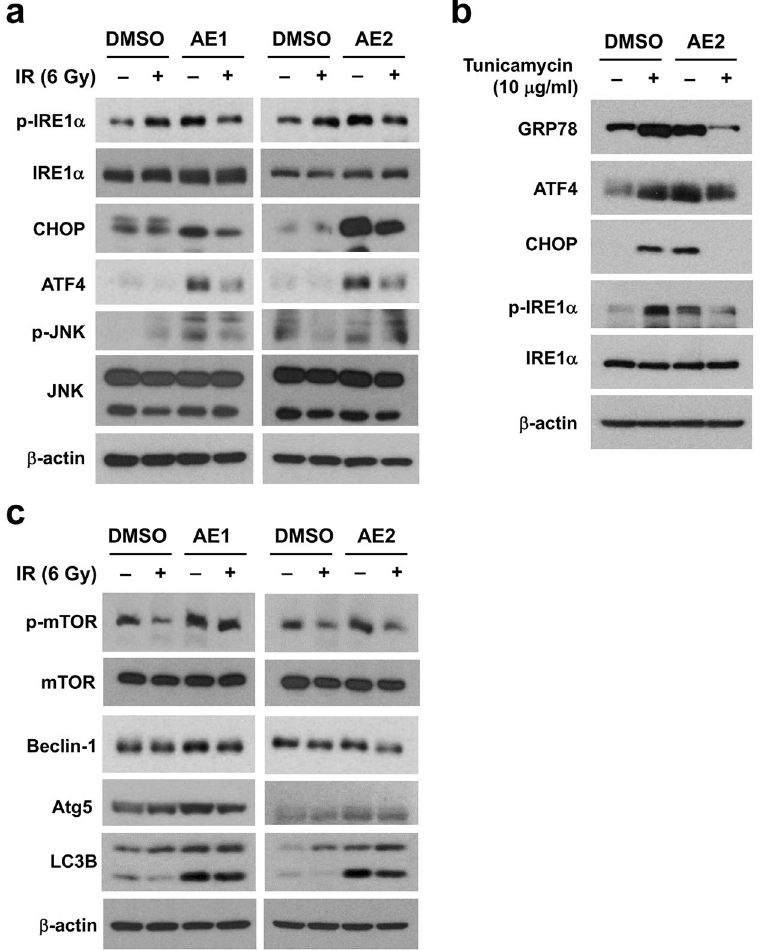
Figure 4. The Agelas extracts induce autophagy by stimulating ER stress. ( a ) Pre-treatment with the Agelas extracts led to induction of ER stress. Hep3B cells were pre-incubated with 10 µ g/mL of AE1 or AE2 for 3 h, followed by 6 Gy of IR. At 24 h post-irradiation, the samples were prepared and subjected to Western blot analysis. Expression of unfolded protein response-related proteins, including phospho-IRE1 α , total IRE1 α , CHOP, ATF4, phospho-JNK and total JNK were upregulated by pre-treatment with AE1 and AE2 but diminished by co-treatment with 6 Gy of IR. β -actin was used as a loading control. ( b ) A g elas extract-induced ER stress signaling was suppressed by tunicamycin, a well-known unfold protein response inducer. Expression of GRP78, ATF4, CHOP, phospho-IRE1 α was induced by either AE2 or tunicamycin, but was suppressed by the combination treatment. (c) Pre-treatment with the Agelas extracts led to induction of autophagy. Treatment with 10 µ g/mL of AE1 or AE2 increased expression of autophagy-related proteins including phospho- mTOR, beclin-1, Atg5 and LC3B-II. Co-treatment with IR suppressed the Agelas extract-induced autophagy. Uncropped images are shown in Supplementary Fig.